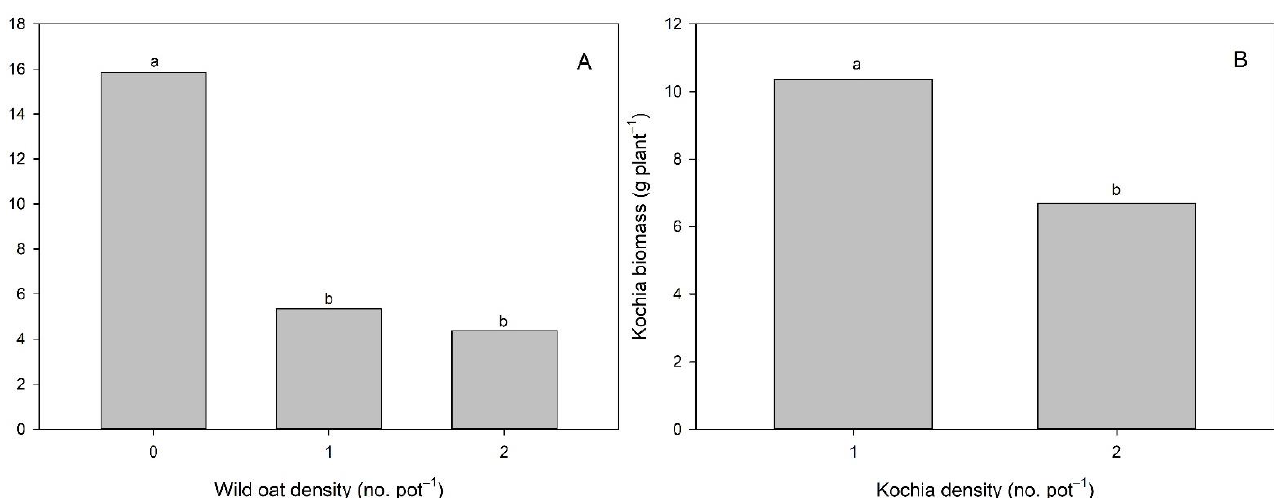
potting soil. Biomass was harvested 81 days after trial initiation.